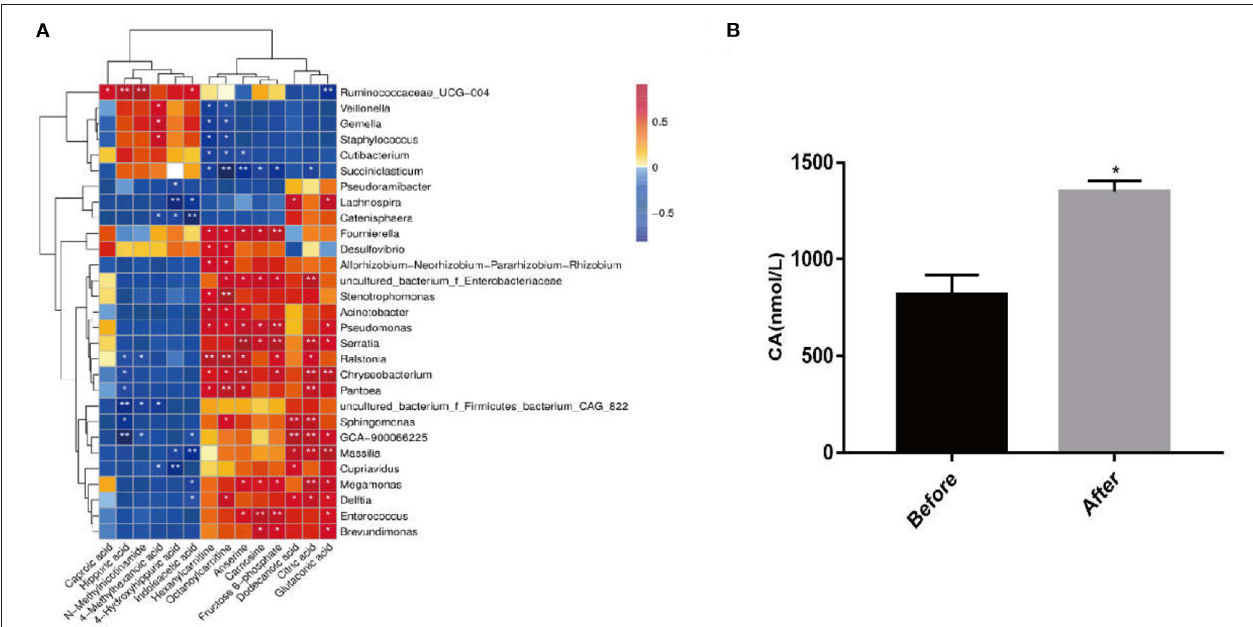
FIGURE 7 | Massilia can produce citric acid. The samples were divided into two groups, the before group (containing only 5mL R2A liquid medium) and the after group (5mL R2A liquid medium with 5 µ L of Massilla , Massilla purchased from GDMCC), placed in a shaker at 28 ◦ C, 200 rpm. The citric acid detection kit was used to detect the citric acid content in the two cultures for 24h. (A) Fecal 16S sequencing results and serum metabolomics for joint analysis. (B) Detection of the content of CA in the culture of Massilia by CA kit ( n = 3, means ± SEM, Student’s t -test, * P < 0.05, ** P <